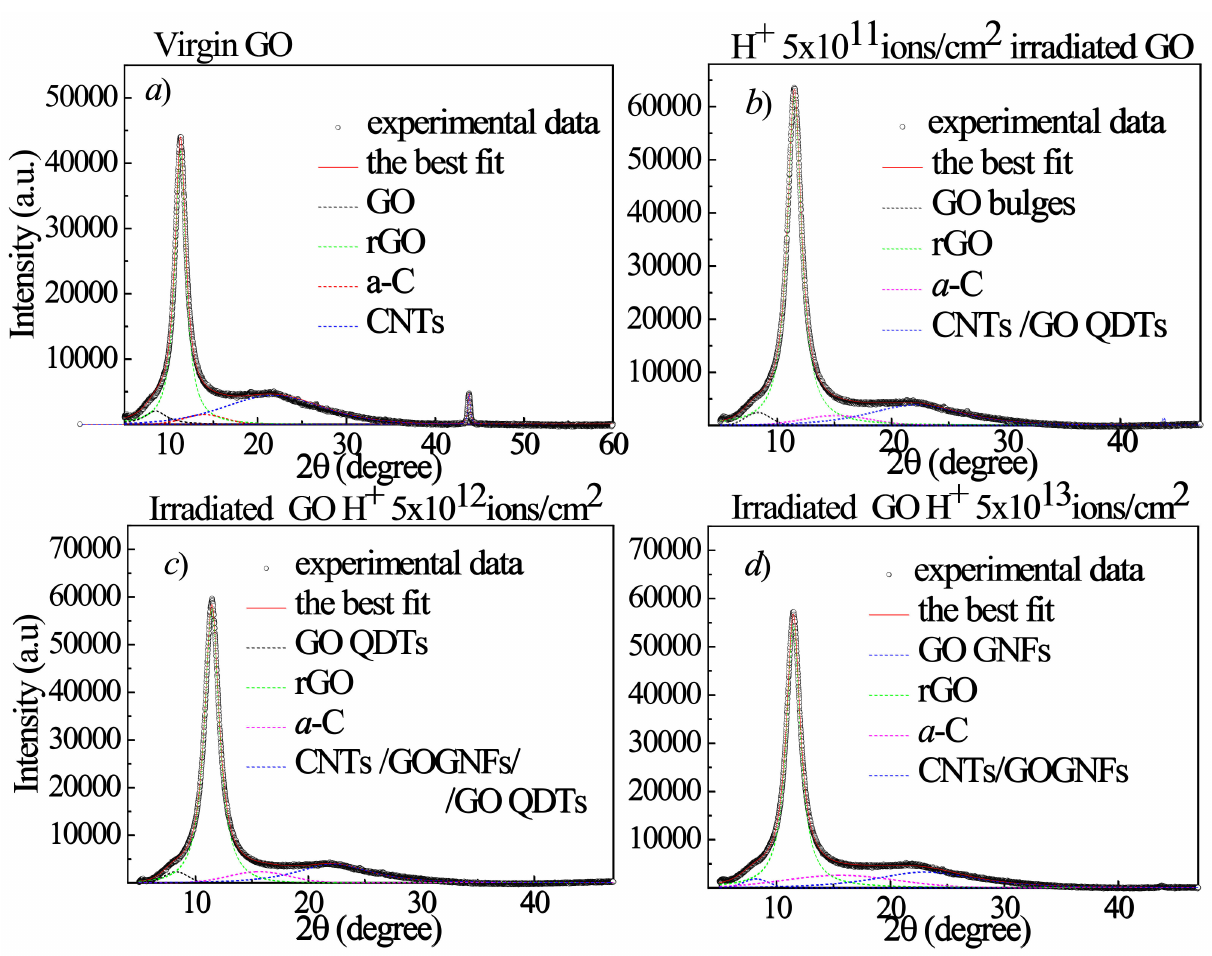
Figure 13. 2 θ / ω XRD curves of the virgin GO sample ( a ) and GO foils irradiated with 3 MeV H + beams at increasing absorbed dose ( b – d